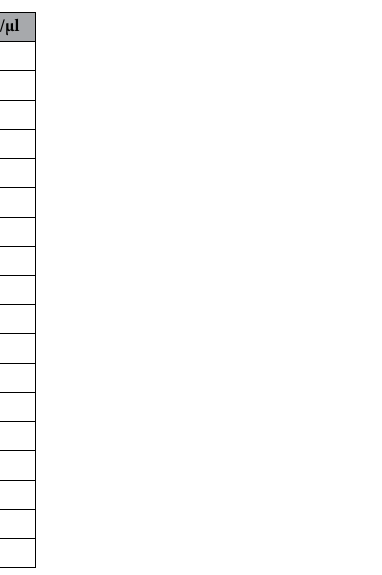
Table 2. Results of digital PCR 2 of PGCs with different genotypes